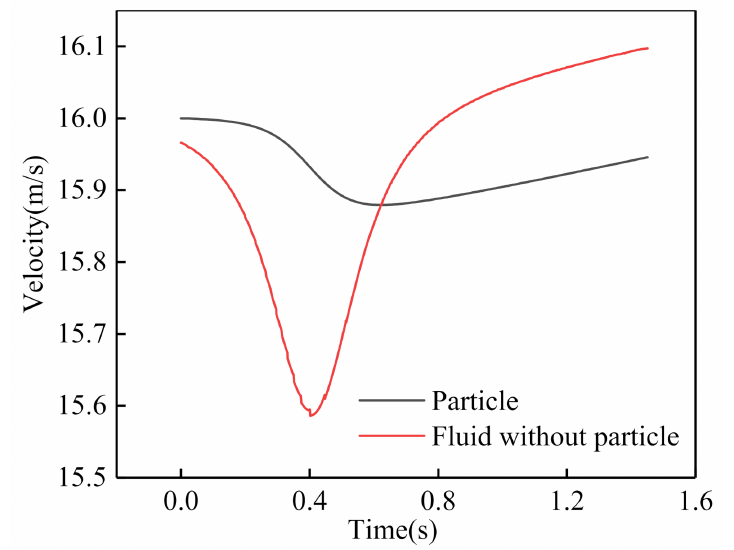
Figure 14. The particle velocity and the particle-free fluid velocity along the trajectory of Particle ID = 5 (particle diameter = 2500 µ